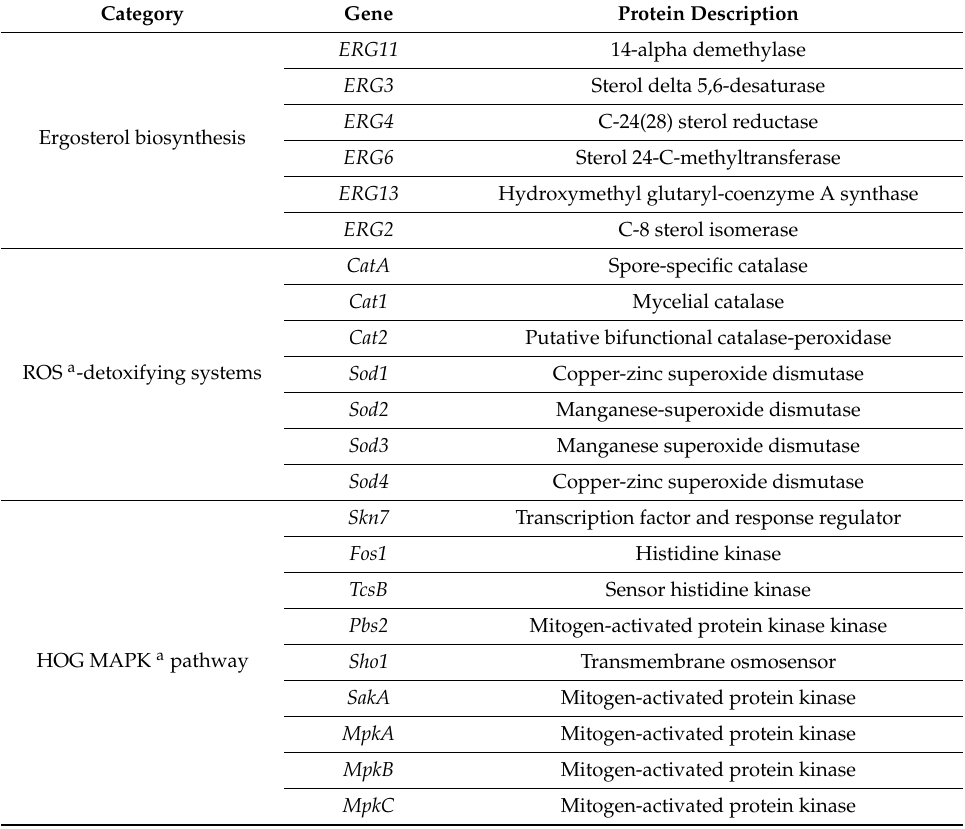
Table 4. Selected genes of interest involved in ergosterol biosynthesis and redox